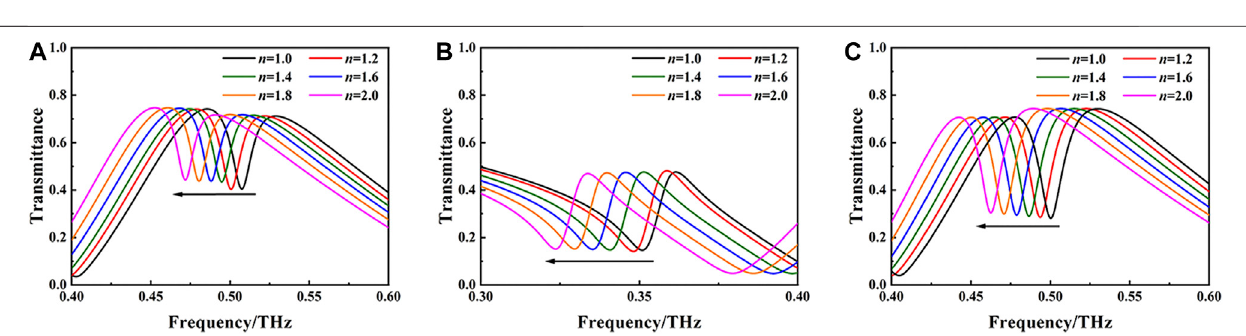
FIGURE 5 | Transmittance in the vicinity of (A) FD 1 , (B) FD 2 , and (C) FD 3 for the asymmetric MM structures coated with a different refractive index of analyte. The thickness of analyte is set to 4 μ m, the asymmetric deviation d for FD 1 is 2.4 μ m, and the asymmetric deviations s for FD 2 and FD 3 are 9 and 6 μ m, Figure 6A . The linear fi tting of FD 3 has the biggest slope,